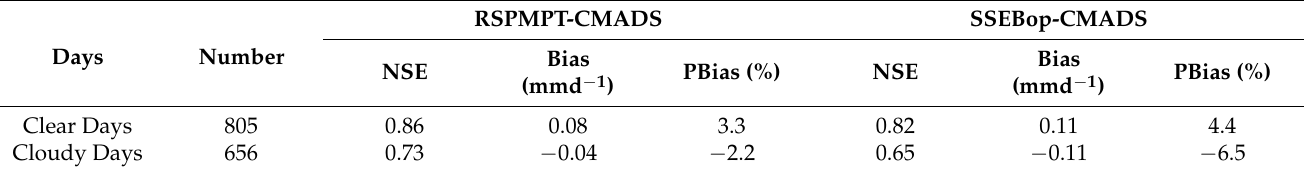
Table 3. The other statistics for the models estimated ET on clear and cloudy days.